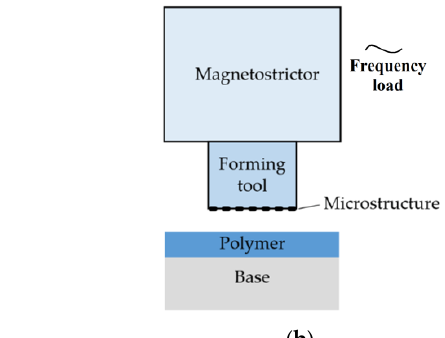
Figure 7. Microstructure forming equipment: 1 — Tensile test machine H10KT (Tinius Olsen, Horsham, JAV), 2 — magnetostrictor, 3 — forming grid, 4 — amplifier PA8HF (Wilcoxon, Gamlingay, England), 5 — signal generator UTG2025A (UNI-T, Hong Kong, China), 6 — power source KPS3010D (wanptek, Shen Zhen, China), 7 — thermometer UT161D (UNI-T, Hong Kong, China). The structures were formed by changing the temperature, forming force, vibration amplitude and frequency. Indentation with the same parameters was repeated 3 times to obtain more accurate results in further measurements. The quality of the structure could be evaluated in various ways, but diffraction is used in this study. A green (525 nm) laser and a high-power laser detector with an energy monitor were both used in the experiment. The experimental equipment is presented in Figure 8b. Each peak was recorded on a computer and processed.